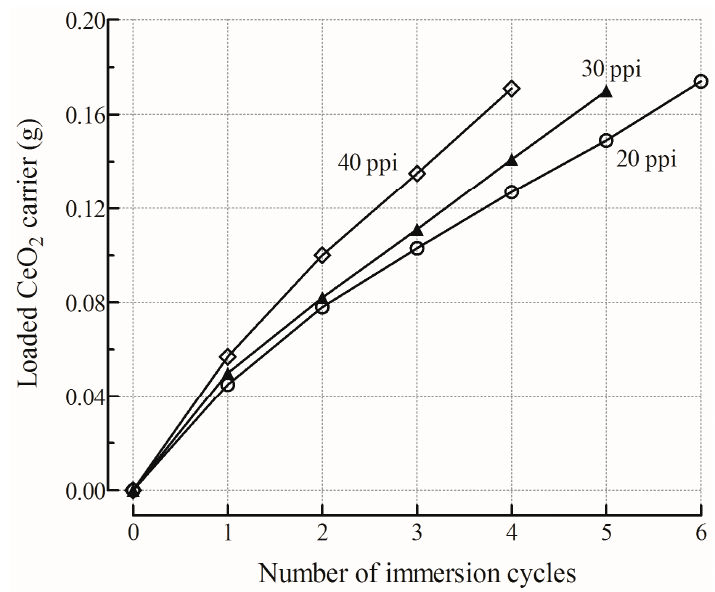
13. Figure 13. Evolution of the loaded CeO 2 carrier after sequential immersion cycles of the different